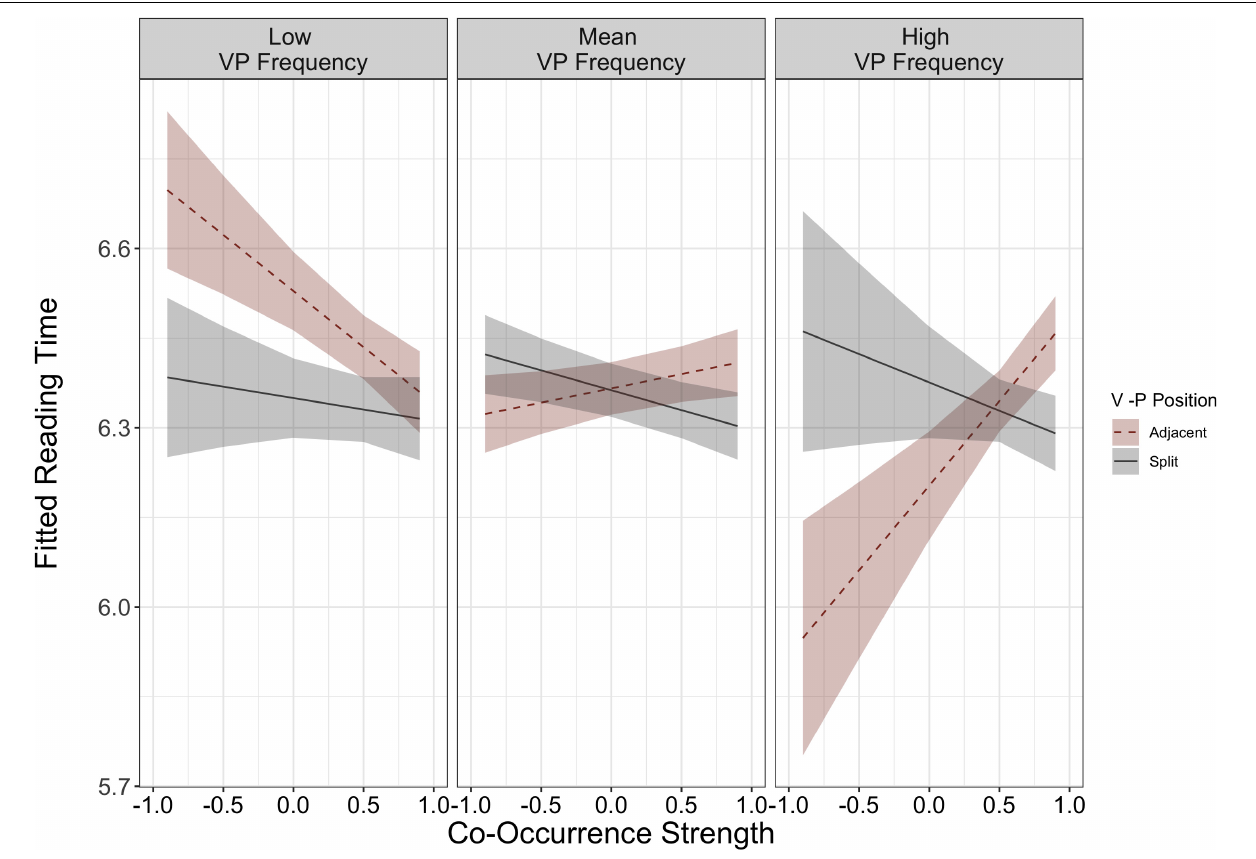
FIGURE 3 | Model fitted L1 reading time for item-specific model (VP Position × Frequency × Co-Occurrence Strength) for Gaze Duration at the VP region. Mean VP frequency presented in middle panel. Low VP frequency illustrates one standard deviation below the mean, and high VP frequency illustrates one standard deviation above the